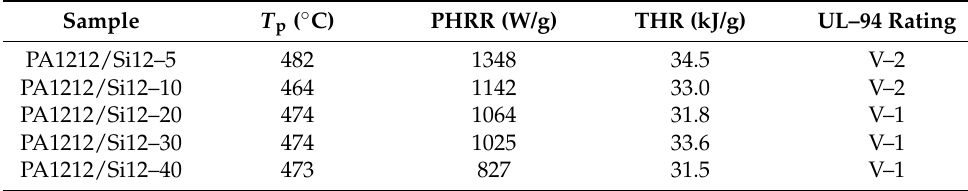
Table 4. Combustion performance of PA1212/Si12